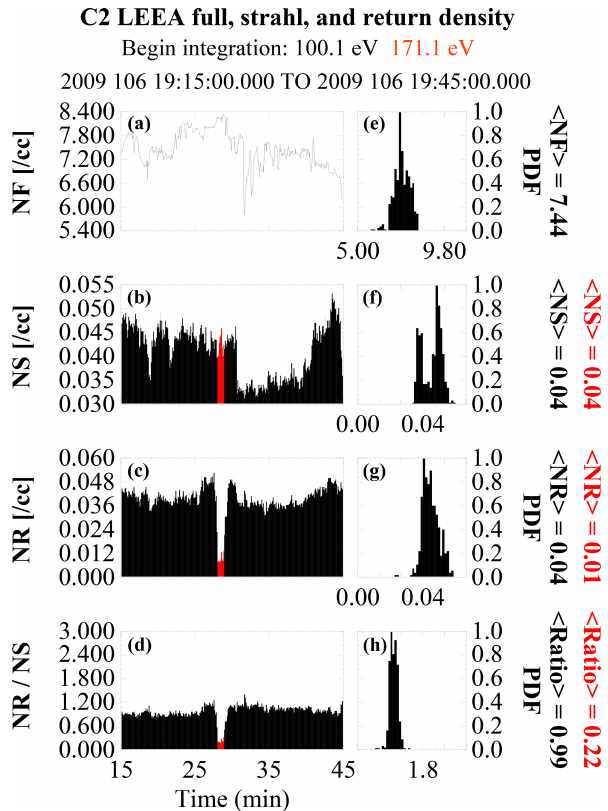
Figure 13. Electron density information across the 15 April 2008 event. From top to bottom, the total, strahl, and return electron den- sities and the ratio of the return to strahl density across the event. Panels (a–d) show the values as a function of time. The red por- tions in (b–d) show when the spacecraft was in the solar wind. Pan- els (e–h) are the corresponding PDF plots of the foreshock density only. The average foreshock and solar wind densities are shown to the right of each PDF plot (red solar wind, black foreshock). The beginning energy integration used to estimate the density in each region is shown at the top.